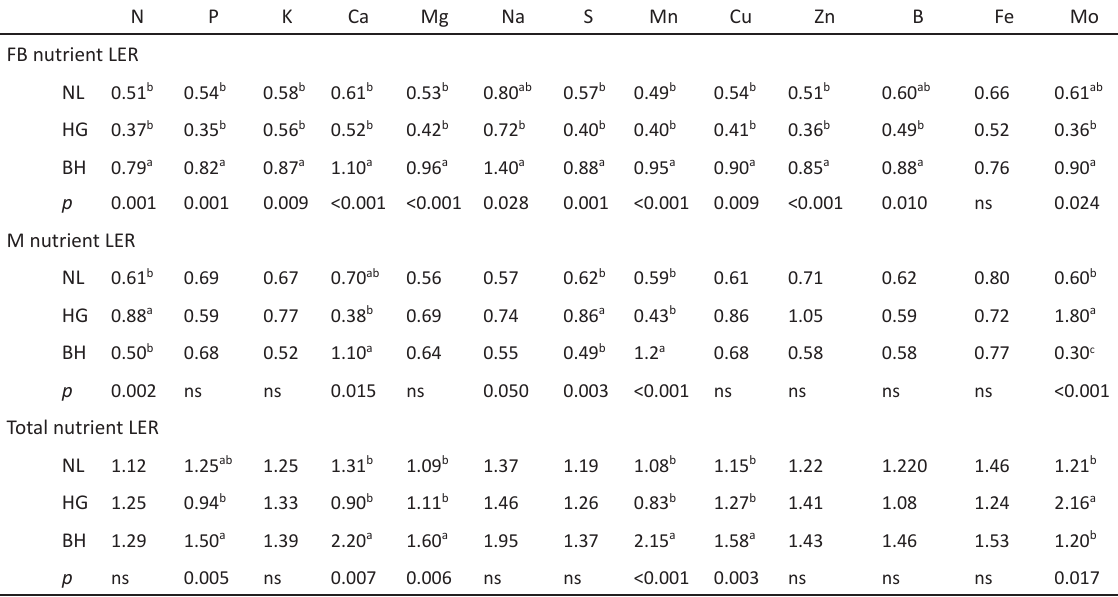
Table 9. Land equivalent ratio (LER) of intercropped faba bean and maize and their total LER of mineral nutrients in three field experiments, n = 4